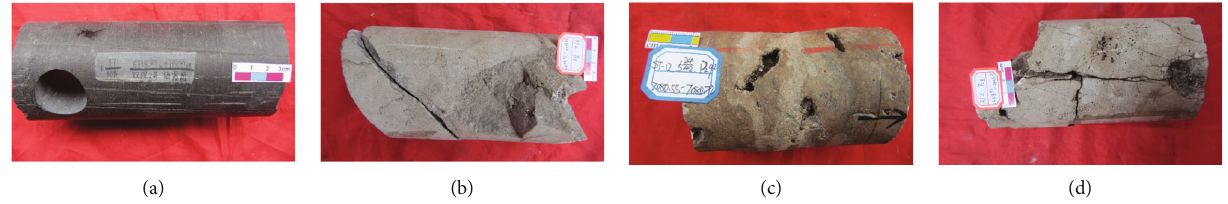
Figure 1: Core sampling of the petrophysical experiment: (a) reservoir with matrix pores, (b) reservoir with matrix pores and fractures, (c) reservoir with matrix pores and vugs, and (d) reservoir with matrix pores, fractures, and vugs.